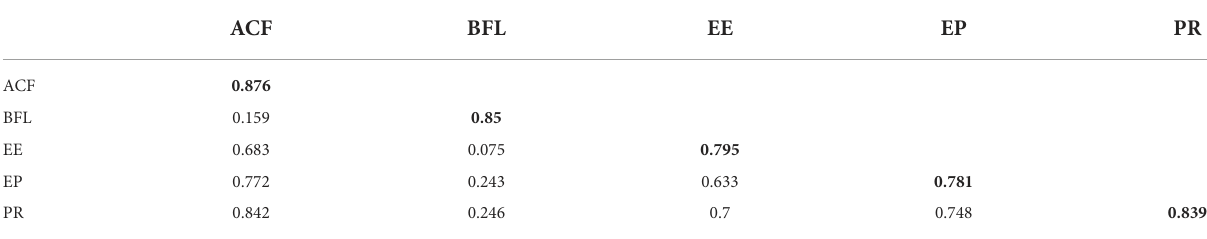
TABLE 3 Fornell and Larcker results.